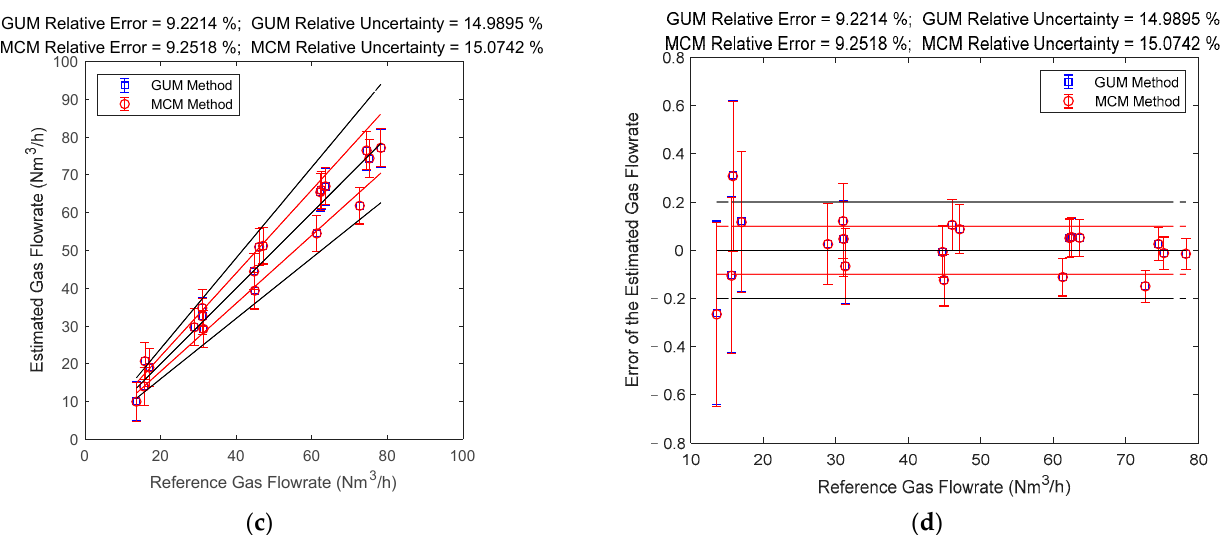
Figure 18. The prediction results of the liquid and gas flowrate of the “CC + DP” method: ( a ) absolute error of the liquid flowrate; ( b ) relative error of the liquid flowrate; ( c ) absolute error of the gas flowrate; ( d ) relative error of the gas flowrate. (The central black line denotes the ideal case with zero error, the upper and lower red lines denote the 10% relative error range, and the upper and lower black lines denote the 20% relative error range. The line segments denote the standard uncertainty whereas the distance between the point and the central black line denote the error. More information can be found in Section 2.4.2).